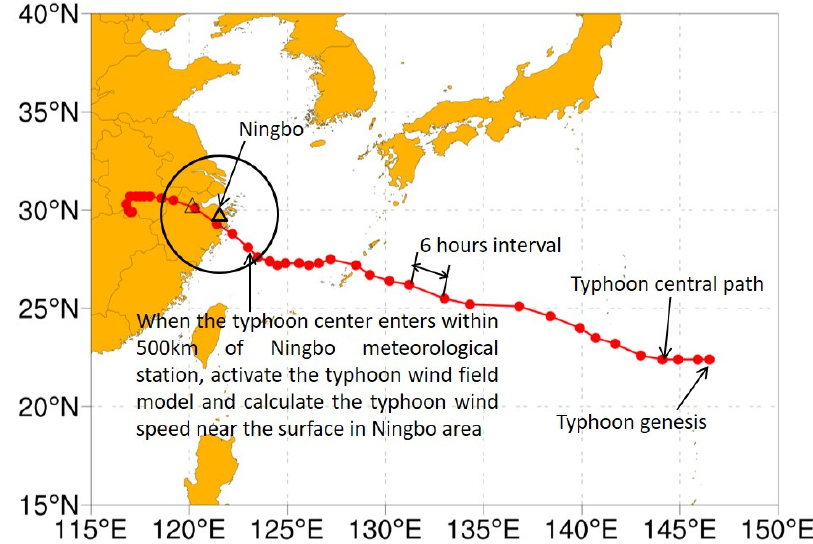
Figure 11. Flow chart of the full-track simulation of a single typhoon.